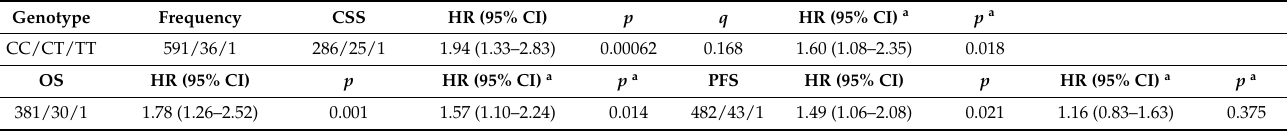
Table 2. Association of NRG1 rs144160282 with CSS, OS, and PFS in prostate cancer patients receiving